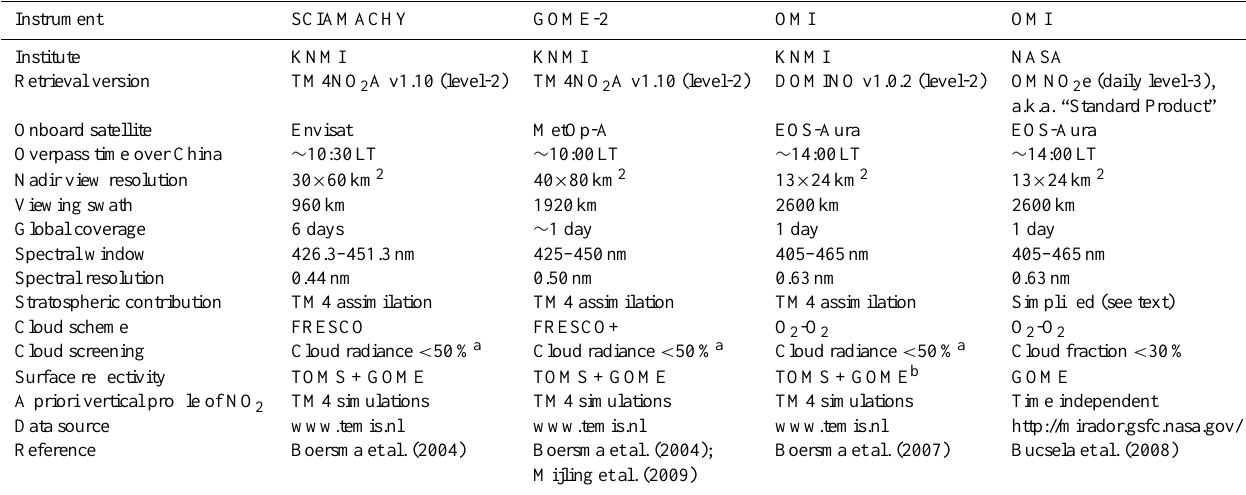
Table 2. Properties of NO 2